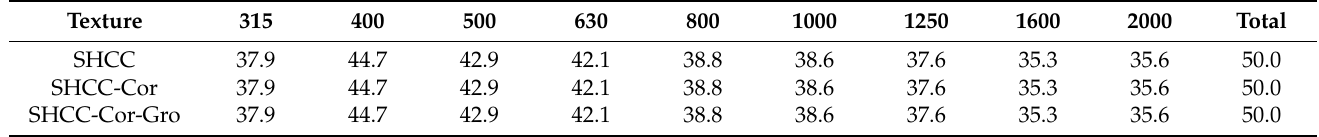
Table 9. Sound level (residual) for SHCC, modified SHCC-Cor, and